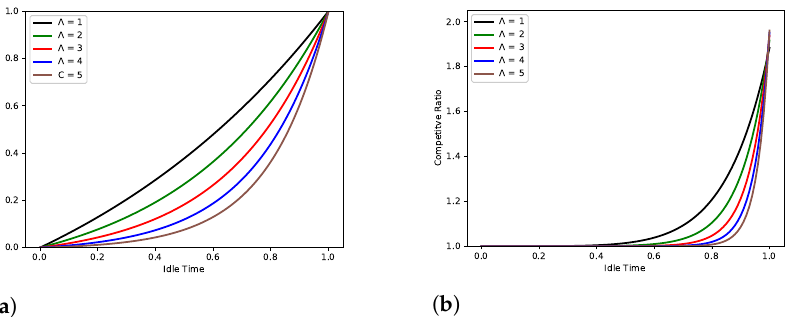
Figure 4. Exponential Strategy. ( a ) Transition rates for exponential strategies, general system; ( b ) competitive ratios for exponential strategies, general